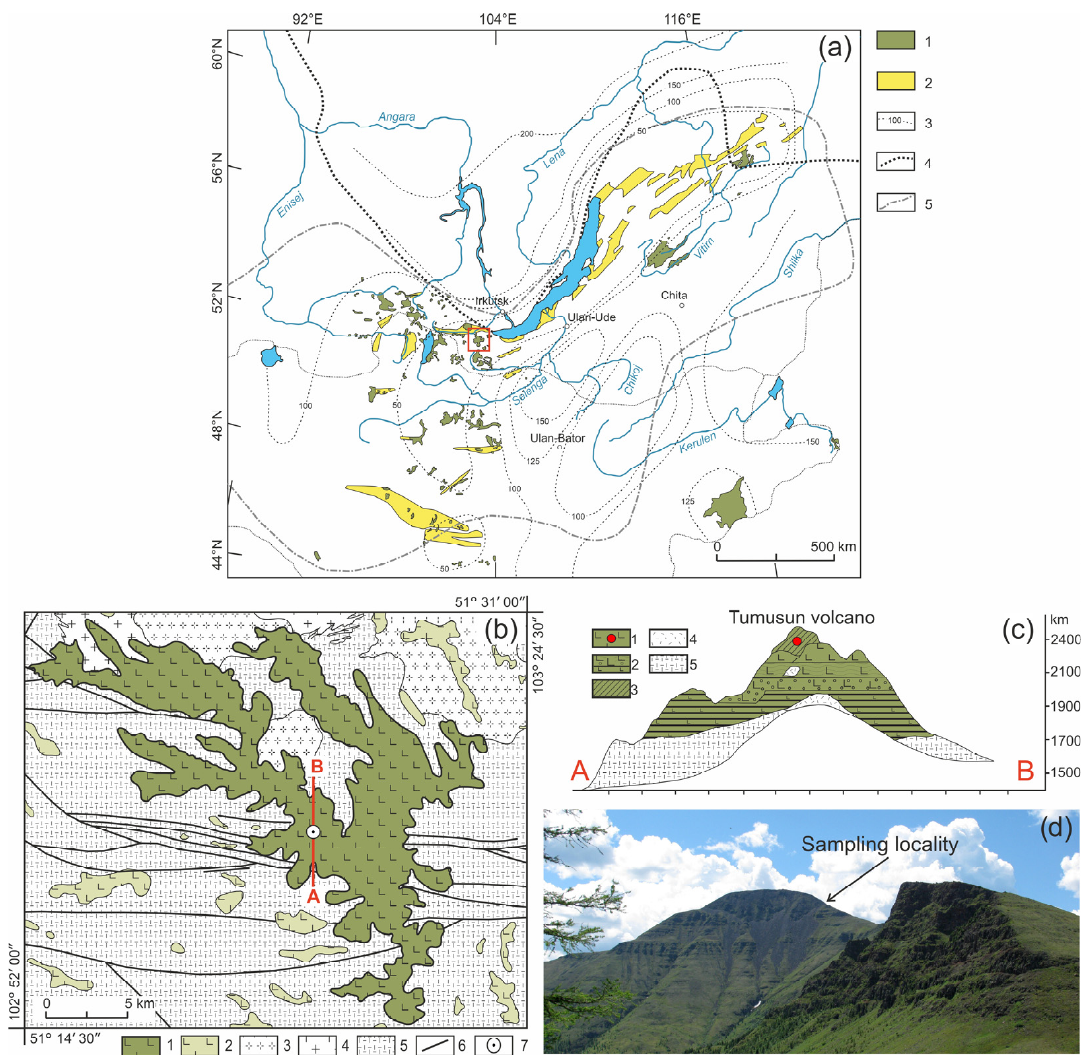
Figure 1. ( a ) Position of the Cenozoic volcanic areas in the Baikal Rift region [21]. 1—Cenozoic volcanic areas; 2—Cenozoic sedimentary basins; 3—lithosphere thickness (in km); 4—boundary of the Siberian Craton; 5—boundary of distribution of anomalous mantle. The red square indicates the study area. ( b ) Geologic scheme of Tumusun area compiled by authors from State geological maps, sheets M48 ‐ I, M48 ‐ II, M48 ‐ VI, and M48 ‐ VII. 1–2—early ‐ middle Miocene lavas of Tumusun plateau and other volcanic areas; 3—early Paleozoic granites and granodiorites; 4—late Proterozoic granites and granite gneisses; 5—metamorphic basement (gneisses and schists); 6—faults; 7—position of Tumusun volcano. The red line is location of cross ‐ section shown in ( c ). ( c ) Cross ‐ section of Tumusun volcano from [9]. 1—flood basalts; 2—interlayering of basaltic lavas, lava conglomerates and sands; 3—basaltic lava flows with xenolith material (marked by red circle); 4—relics of tefrite basalts; 5—metamorphic basement (gneisses and schists). ( d ) Landscape photo ‐ graph of the Tumusun volcano with xenolith sampling locality. The composition of lithospheric mantle beneath the Baikal Rift Zone and adjacent regions was studied by many authors [9,10,21,22]. One of the mantle xenolith localities is the Tumusun volcano (51°19 ′ 19 ″ N, 103°14 ′ 48 ″ E), which is located within the Khamar ‐ Daman Range at watershed between the Tumusun and Utulik Rivers. The Tu ‐ musun volcano is one of the largest erupting centers among the other Neogene basaltic areas of the Khamar ‐ Daban Range (Figure 1b). The thickness of Tumusun lava flows is up to 500 m. The rock types are alkaline olivine basalt, hawaiite and, rarely, basanite. The volcanic sequence starts with voluminous eruptions of olivine basalt and hawaiite, which comprise a major lava plateau, and ends with the formation of the Tumusun neck com ‐ posed of basanite. The lavas of volcanic plateau were dated by the 40 Ar/ 39 Ar method at 16.9 ± 0.3 and 15.2 ± 0.2 Ma, and basanite of the Tumusun neck was dated at 12.6 ± 0.3 Ma [17]. Therefore, basanite magmas erupted on final stages of Tumusun volcano develop ‐